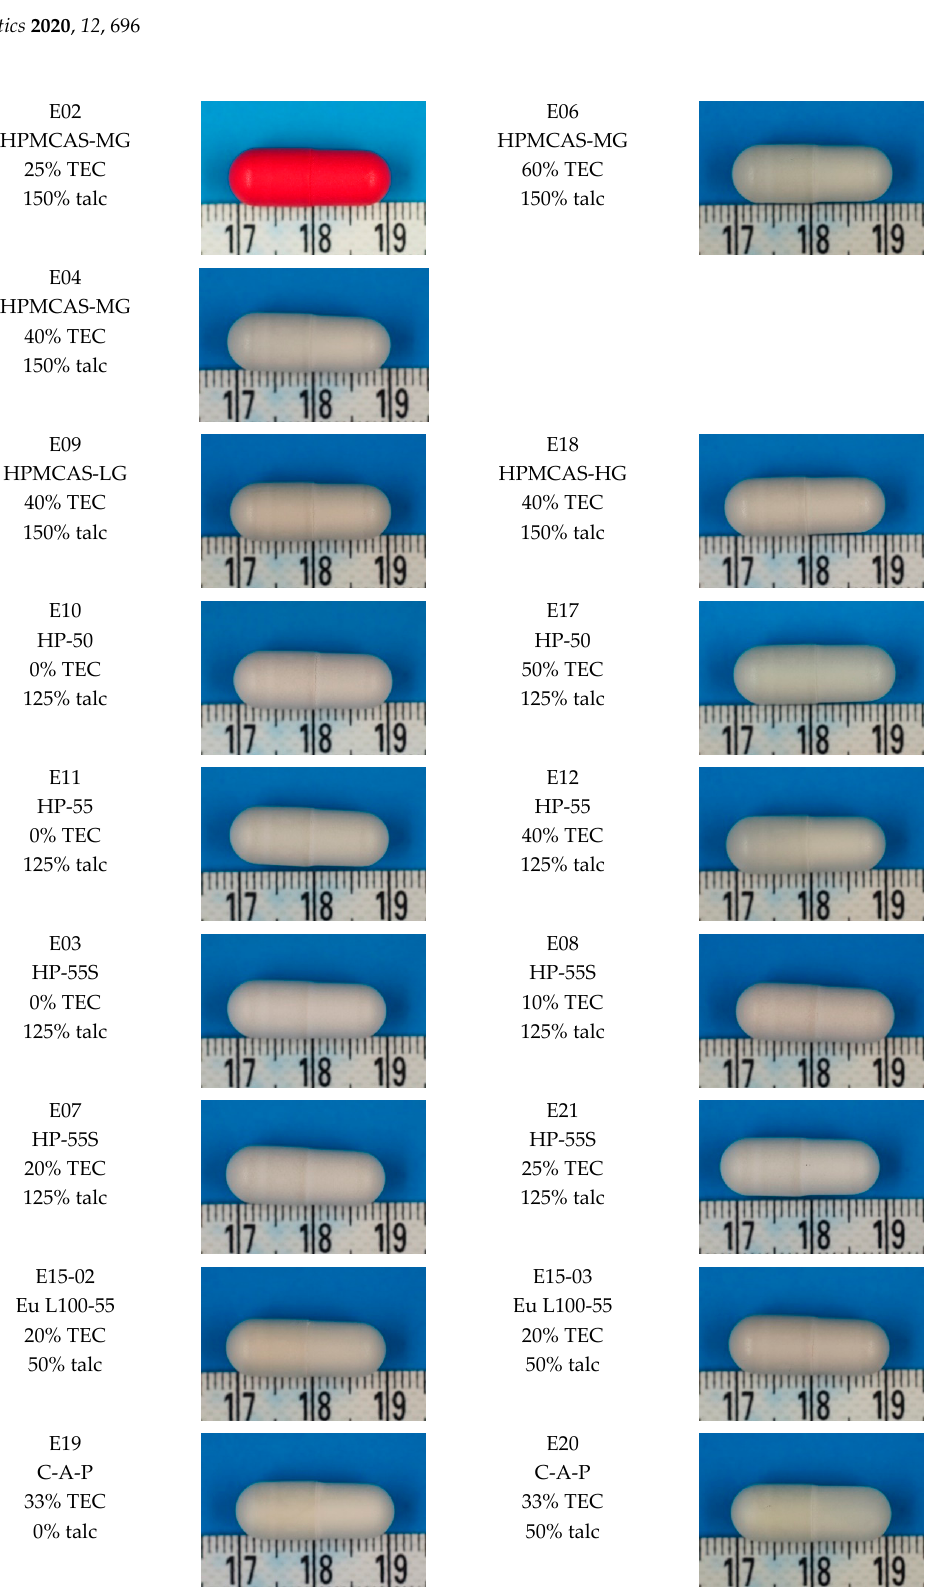
Figure 1. Surface structure of enteric-coated HPMC capsules. % TEC and talc are based on dry polymer weight.